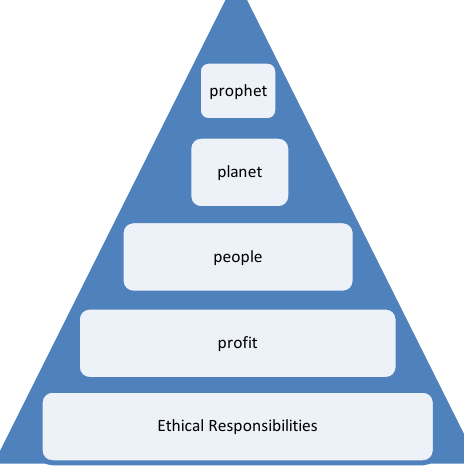
Figure 1: Pentuple Bottom Line Hierarchical